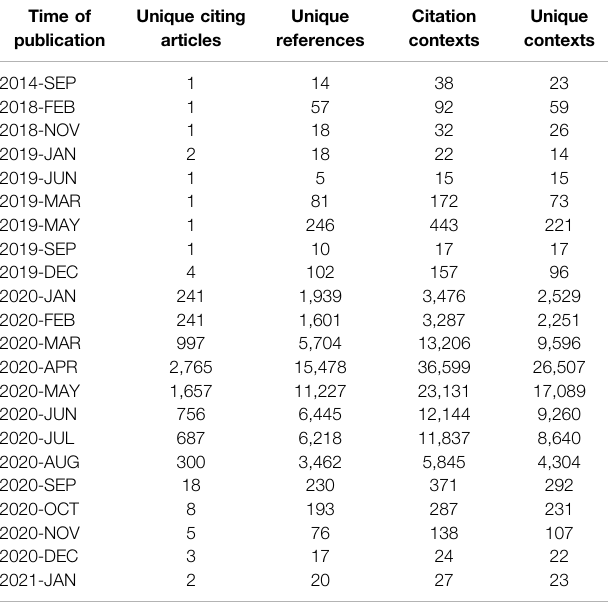
TABLE 1 | A self-constructed dataset of the COVID-19 literature on Microsoft Academic Graph as of September 5, 2020.